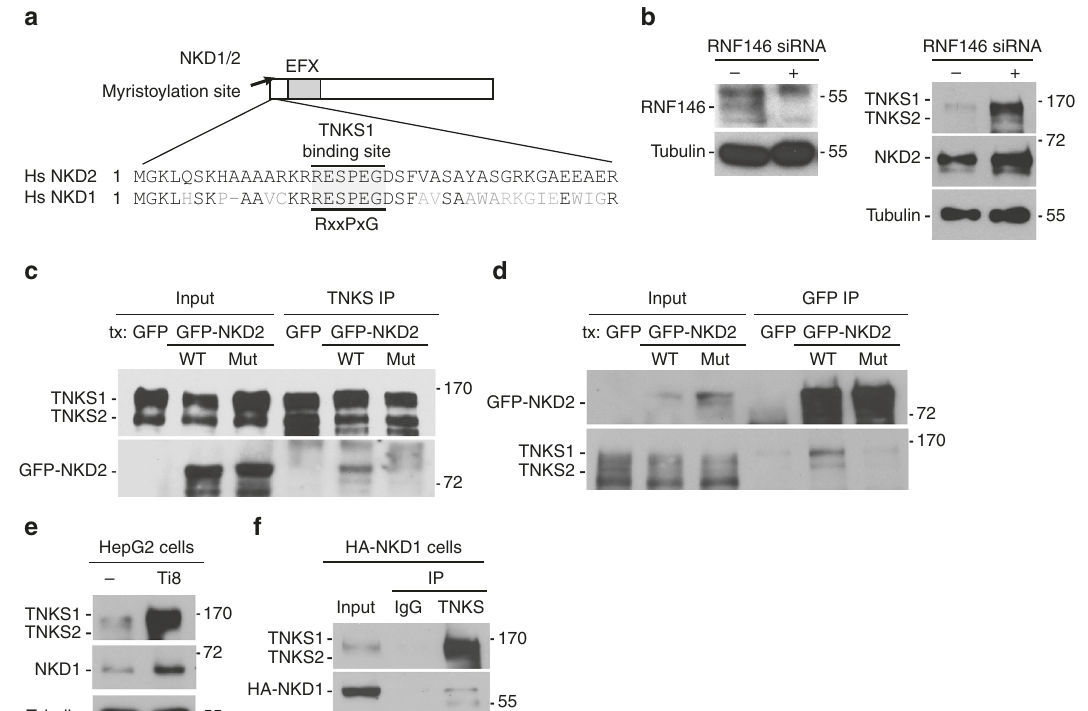
TNKS1 binding site